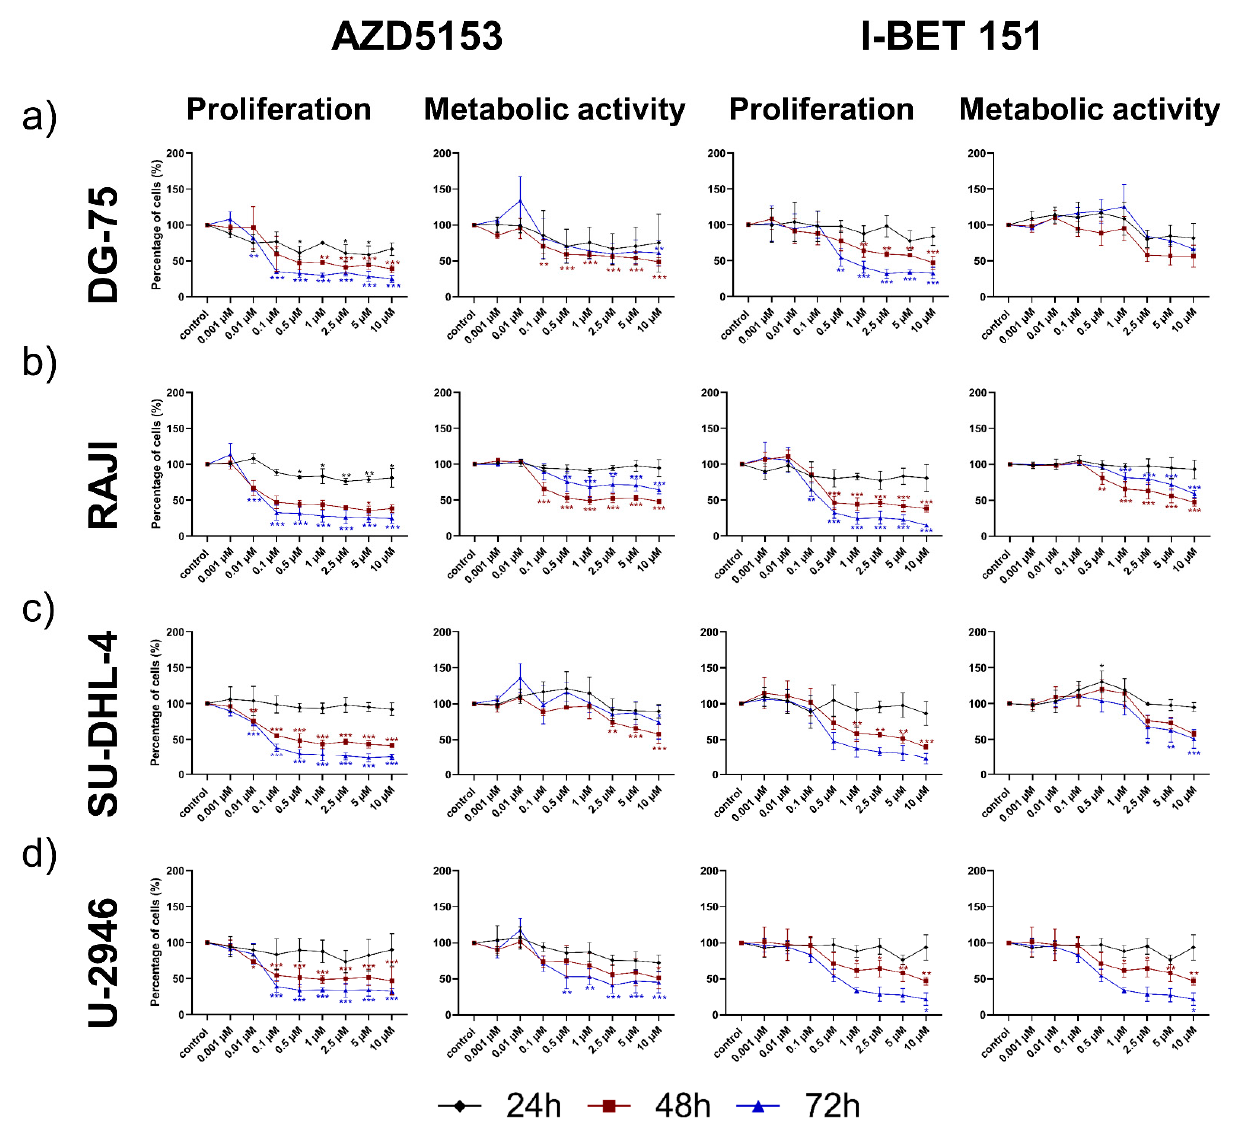
Figure 1. Evaluation of cell viability after isoform-specific- and pan-BET inhibition in Burkitt‘s lymphoma and diffuse large B-cell lymphoma cell lines. Burkitt‘s lymphoma (BL) cell lines ( a ) DG-75 and ( b ) RAJI; and diffuse large B-cell lymphoma (DLBCL) cell lines ( c ) SU-DHL-4 and ( d ) U-2946 were exposed to serial-diluted isoform-specific inhibitor AZD5153 or pan-BET inhibitor I-BET151 (0.001 µ M–10 µ M). Cell proliferation was determined by trypan blue staining and metabolic activity by WST-1 assay 24 h, 48 h and 72 h after exposure. Data are presented as the mean ± SD. Statistical significance was calculated by one-way ANOVA followed by Dunnett’s multiple comparison test as post hoc analysis. The Kruskal–Wallis test was applied to non-parametric data. Statistical significance is displayed as * p < 0.033, ** p < 0.002, *** p < 0.001 versus control group (n ≥